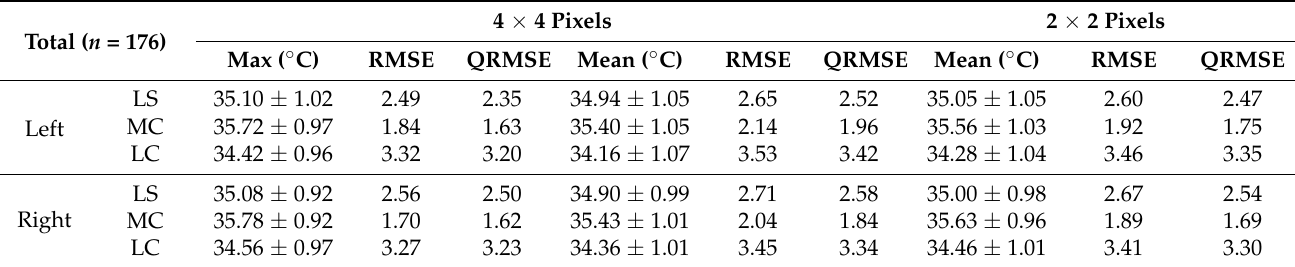
Table 3. Maximum, mean temperature, root mean square error (RMSE), and quantile RMSE (QRMSE) of the three ROIs in the horse’s eyes for each rectal temperature (RT, ◦